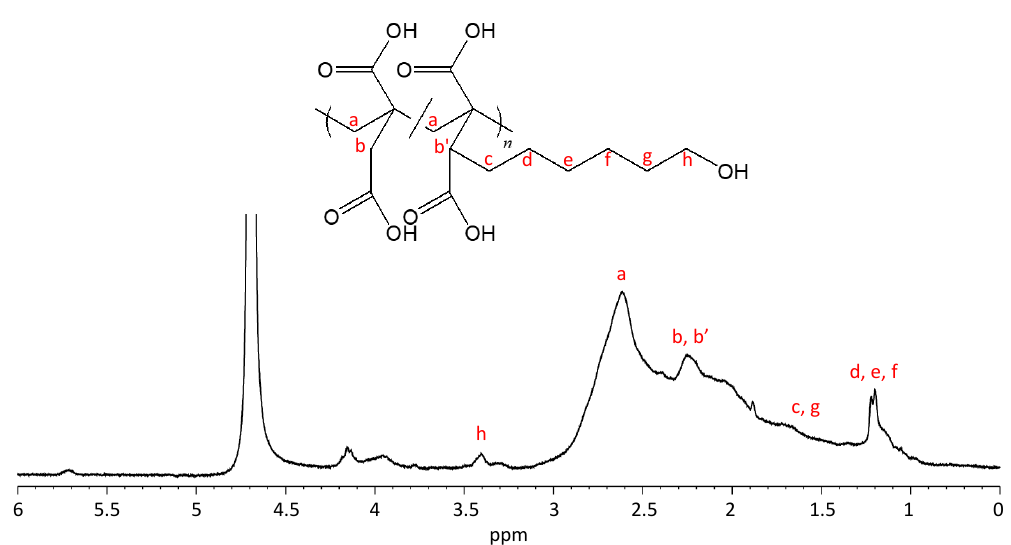
Figure 2. 1 H NMR spectrum of poly(IA- co -10-HHIA) synthesized with an IA / 10-HHIA monomer ratio of 100 / 100 µ mol (code 3). The letters indicate the positions of protons and their corresponding signals.